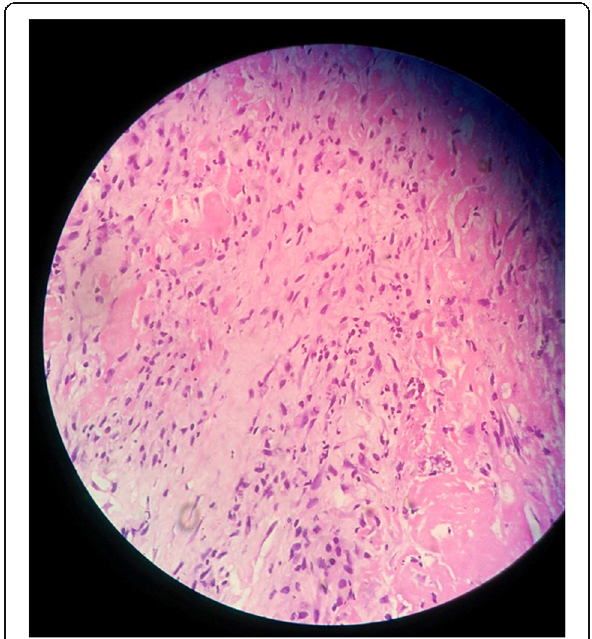
Fig. 2 12 – 14 PMNs/ HPF on frozen section of femoral sample from a